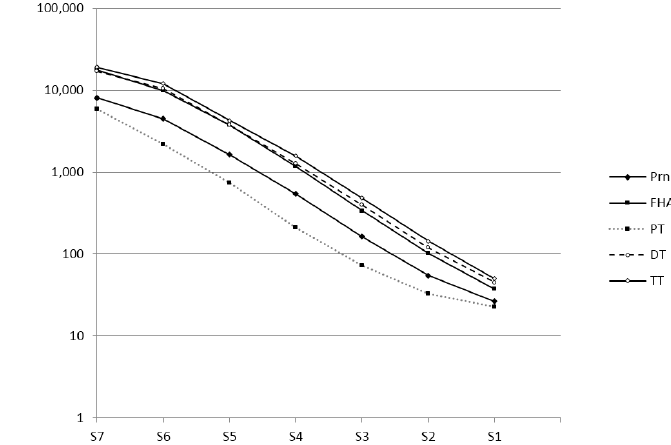
Figure 1. In-house standard curves for diphtheria toxin (DT), tetanus toxin (TT), pertussis toxin (PT), filamentous hemagglutinin (FHA) and pertactin (Prn) of seven four-fold serum dilutions, with serum (S)7 being the initial dilution of 1:100 and S1 being the last dilution of 1:409,600. The curves represent the mean fluorescence intensity of each serum dilution for each analyte on a log scale.